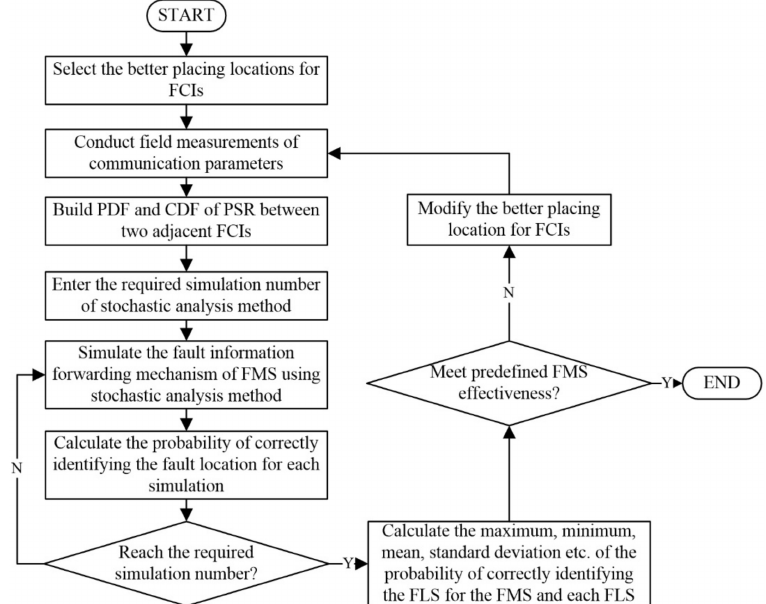
Figure 13. Flowchart of proposed systematic effectiveness assessment methodology. CDF: Cumulative Distribution Function; PDF: Probability Distribution Function; PSR: Packet Success Rate; FMS: Fault Management System; FLS: Faulted Line